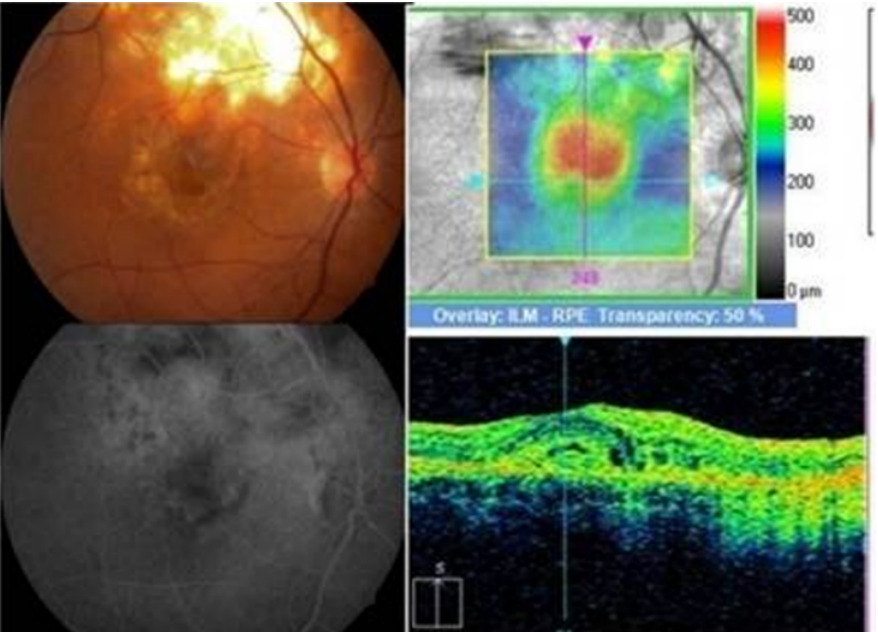
Figure 8: Juxtafoveal yellowish white lesion adjacent to healed scar with retinal edema, subretinal blood, exudates and subretinal fluid. FFA and SD-OCT showed signs of active choroidal neovascular membrane at the margin of the scar.